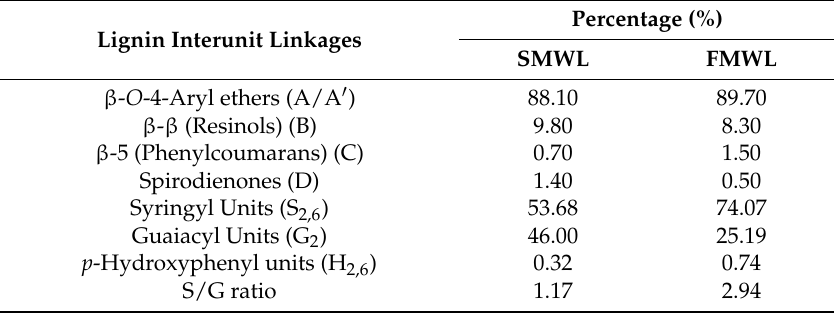
Table 3. Quantification of the FWML and SMWL by quantitative 2D HSQC method.